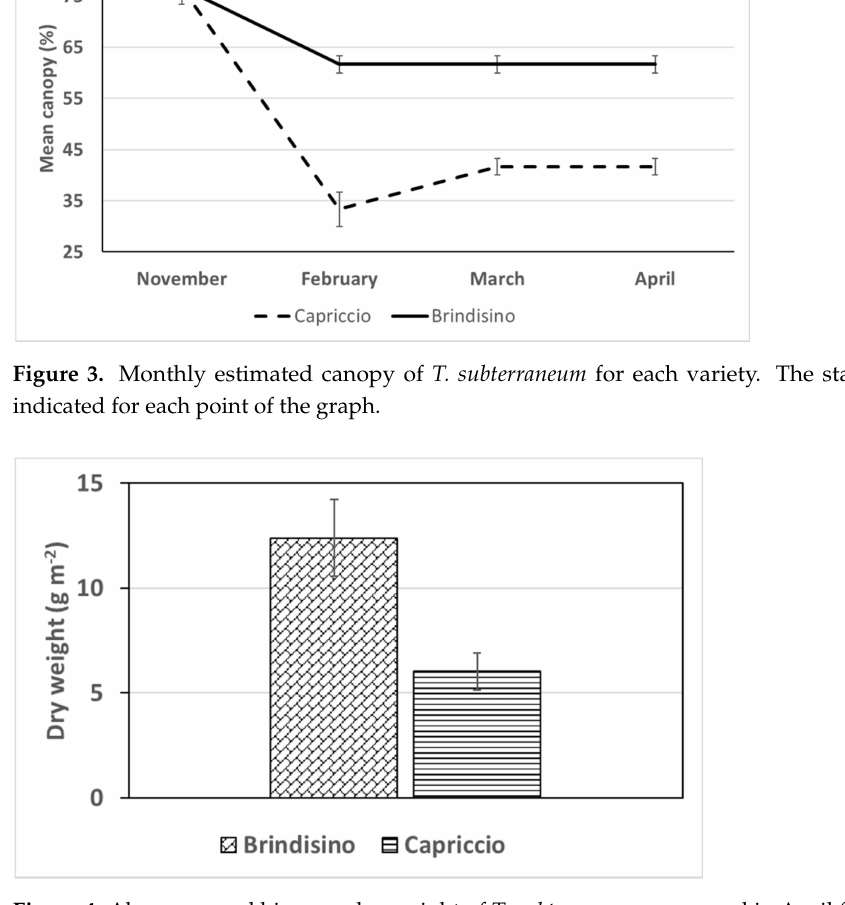
Figure 4. Above ground biomass dry weight of T. subterraneum measured in April for each variety. The standard error is indicated for each